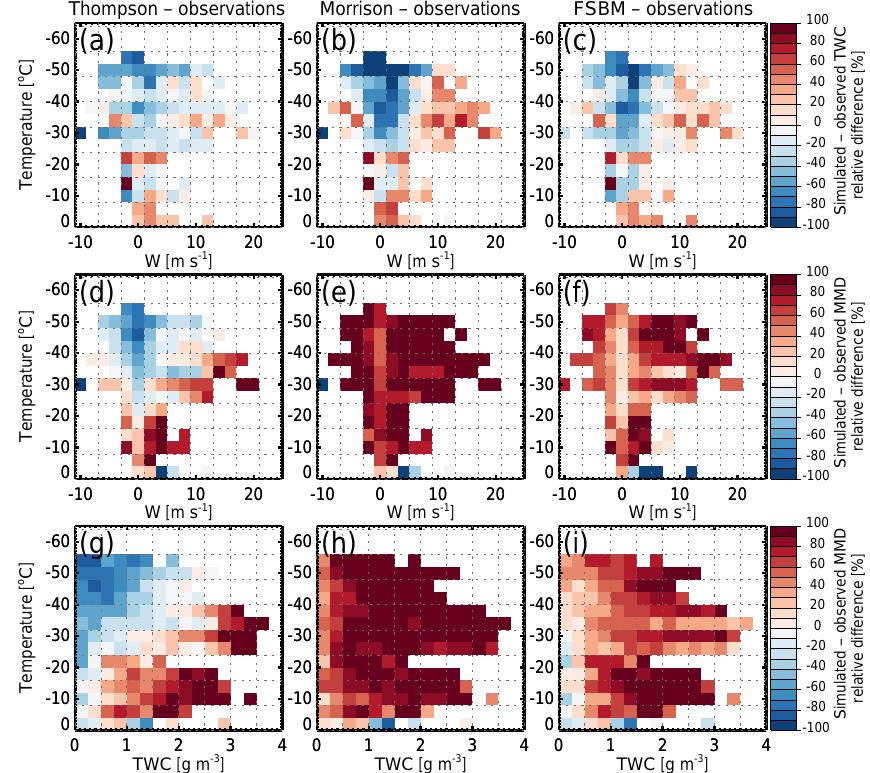
Figure 7. Joint histograms color-filled with relative differences between observed and simulated (a) – (c) TWC as a function of w – T bins, (d) – (f) MMD as a function of w – T bins, and (g) – (i) MMD as a function of TWC– T bins. Differences for the Thompson scheme are shown in the left column, the Morrison scheme in the middle column, and the FSBM scheme in the right column. Observed values are subtracted from simulated values, and only bins where observational data are available are